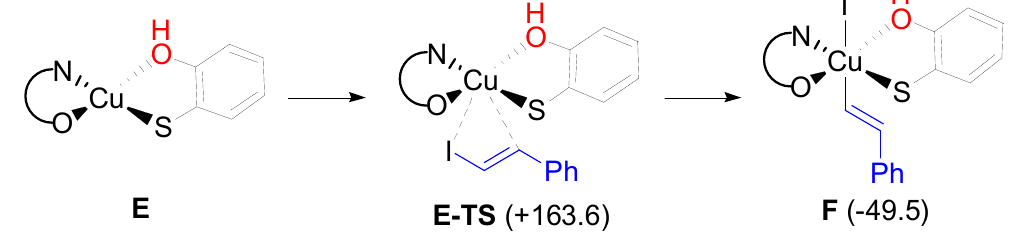
Scheme 7. Oxidative addition.